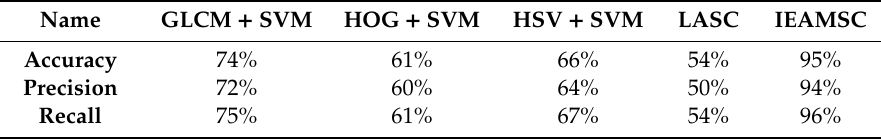
Table 3. Comparison of detection results of di ff erent methods based on image